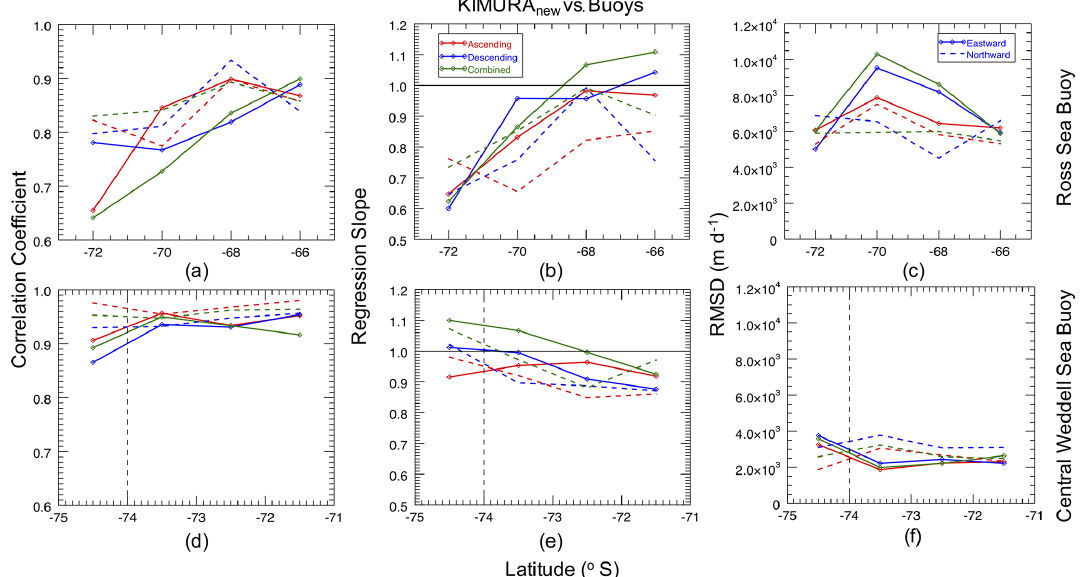
Figure 7. Comparison between KIMURA new dataset (ASC is red, DES is blue, and combined is green) and buoy velocity using (a, d) correlation coefficient, (b, e) regression slope, and (c, f) RMSD. Vertical dashed lines in the central Weddell Sea panels (lower row) mark the latitude of the AMSR2 swath discontinuity (74 ◦ S) shown in Fig. 2.